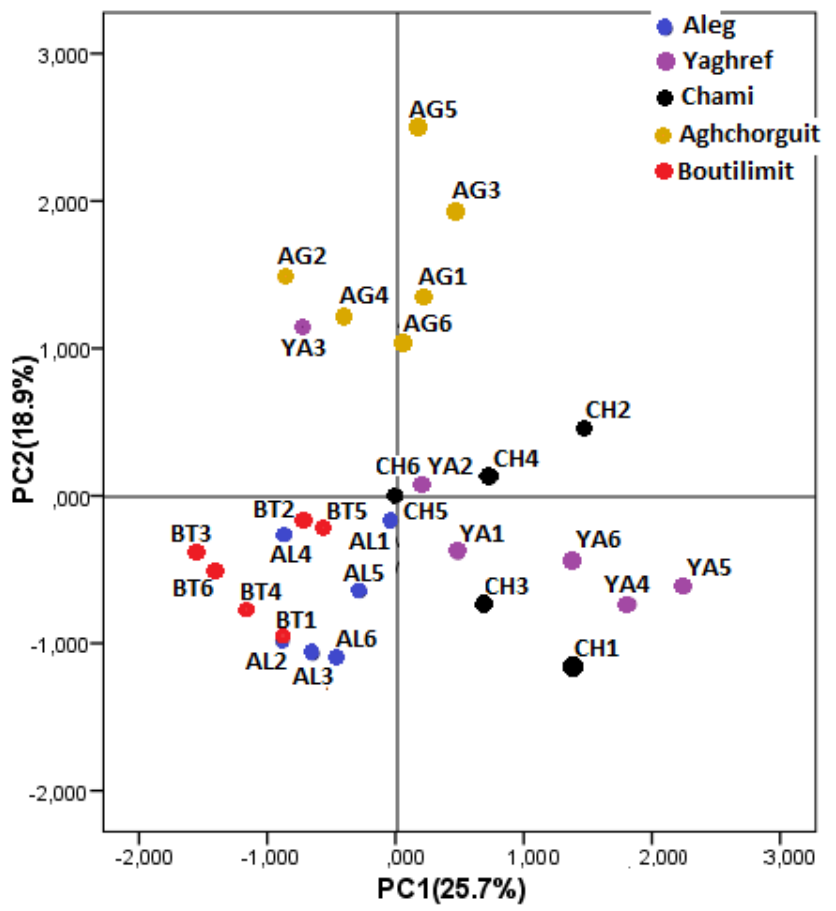
Figure 1. Principal component analysis plots (axis 1–2) of 30 Balanites aegyptiaca trees from 5 locations in Mauritania based on fruit morphological and phytochemical components.